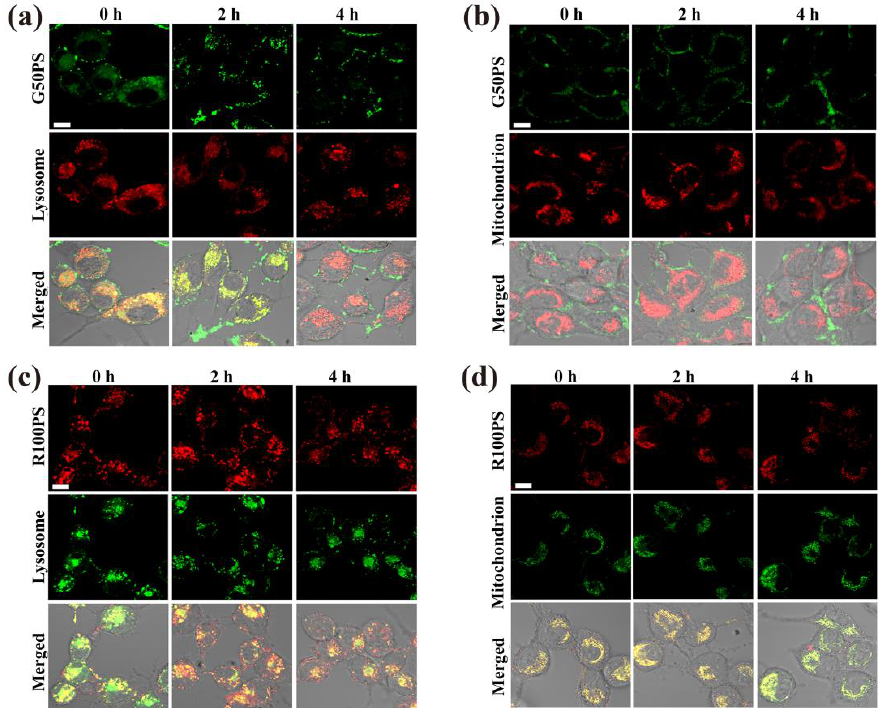
Figure 10. CLSM images of PS NPs in lysosomes ( a , c ) and mitochondrion ( b , d ) during exocytosis in BEAS-2B cells. Cells were pre-incubated with 20 µ g/mL G50PS ( a , b ) and R100PS ( c , d ) for 4 h and then incubated in fresh culture medium for 0, 2, and 4 h. The scales represent 10 µ